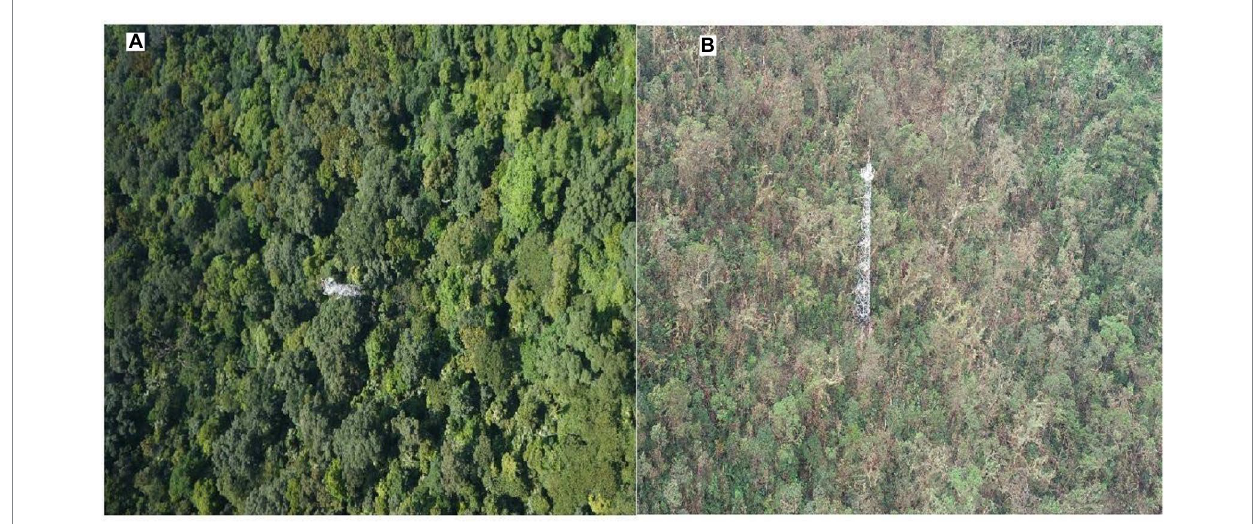
FIGURE 1 Figure showing landscape of the study site location before (A) and after (B) the typhoon.